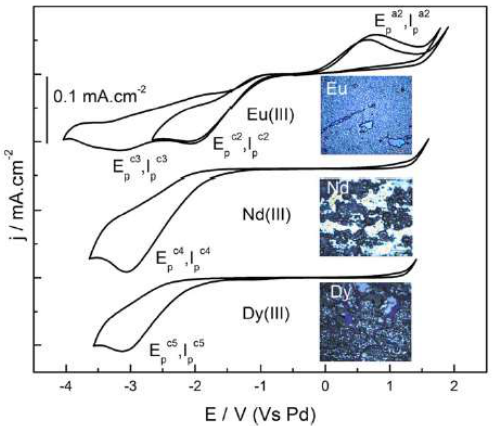
Figure 6. Cyclic voltammograms of 100 mM [Ln(NTf 2 ) 3 ] in DHOA medium recorded at glassy carbon working electrode at the scan rate of 50 mV s − 1 at 353 K. Insets show the photographs of the electrodeposits obtained at the working electrode after electrolysis of 100 mM Ln 3 + in the system DHOA / [bmim][NTf 2 ] at − 3.0 V for about 2 h. Reproduced with permission from